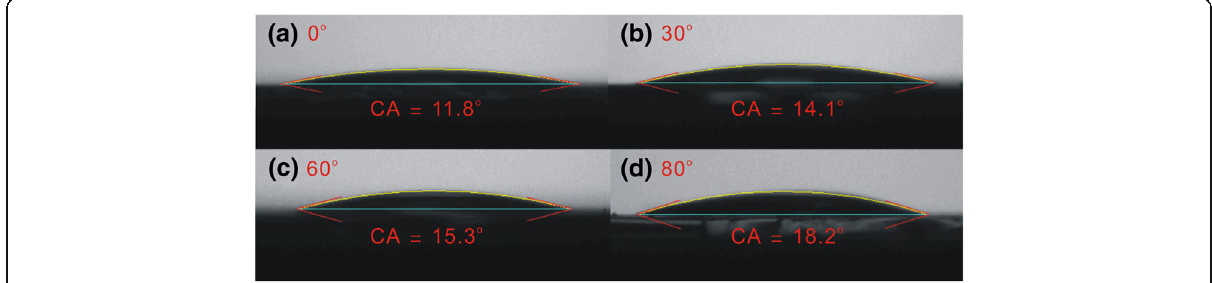
Fig. 4 a – d Images that show contact angle of water on PEDOT:PSS/oblique ITO layer/glass for various oblique angles. CA contact